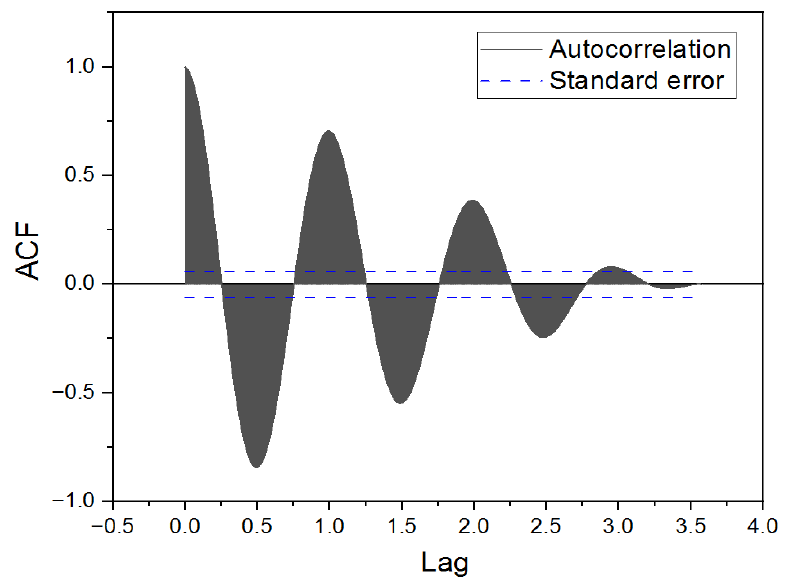
Figure 7. Autocorrelation coefficient of long-term SCS calibration coefficient. The horizontal axis is the time series seasonal cycle number and the vertical axis is the autocorrelation coefficient.